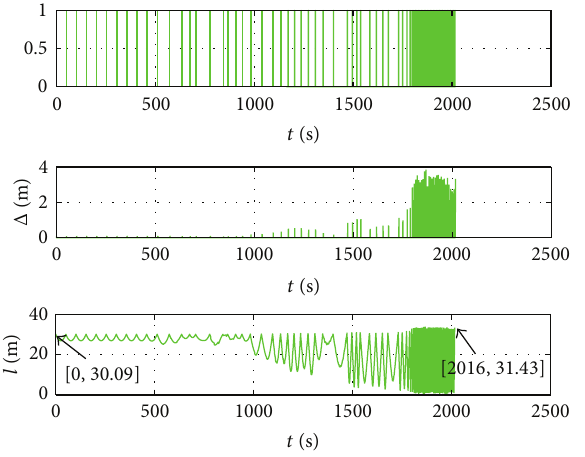
Figure 16: The tensional ( 1 ) and tensionless (0) states, the elonga- tionofthetether( Δ ),andthedistance( 𝑙 )betweenthetwospacecraft.